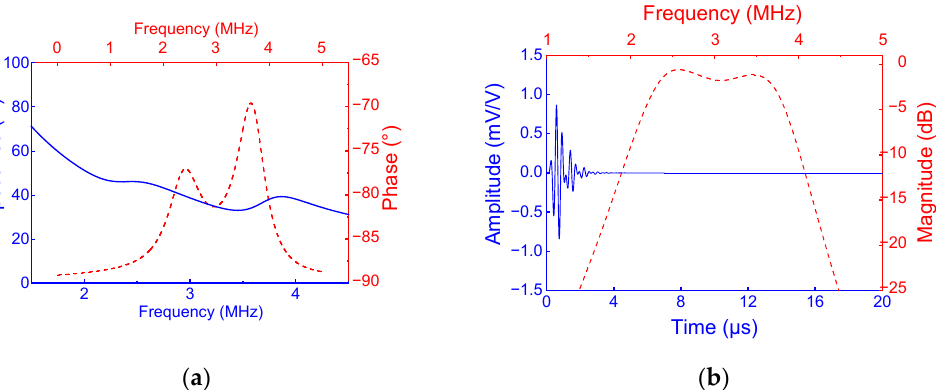
Figure 7. ( a ) Simulated electrical magnitude and phase angle; ( b ) pulse-echo wave and frequency spectrum performances of the transducers.